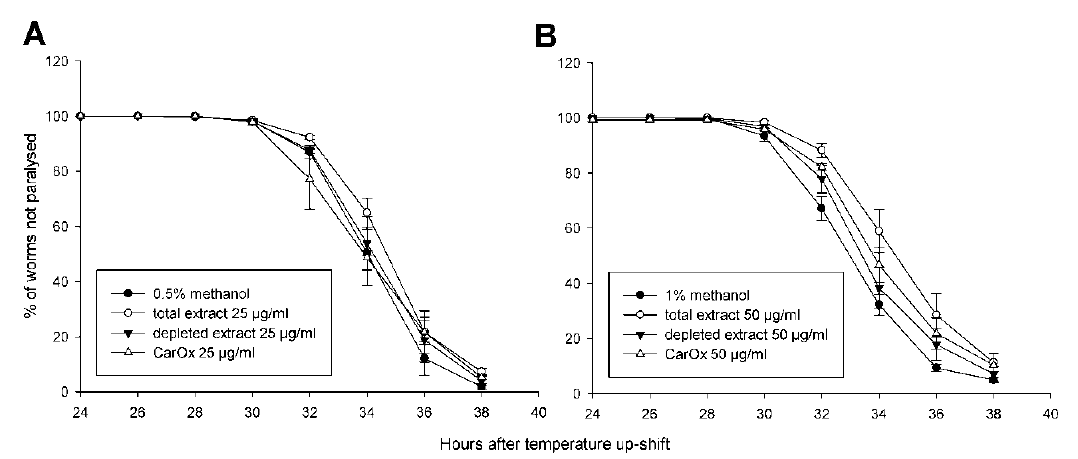
Figure 5. Paralysis curves for C. elegans expressing A β (CL4176) treated with dichloromethane extract of C. acaulis (Carlina), depleted extract, or CarOx in concentrations 25 μ g/mL ( A ) and 50 μ g/mL ( B ) with respective solvent controls. Table 1. PT 50 values in hours for the treatments in paralysis assay (Figure 5). Significance was tested against the corresponding solvent control.